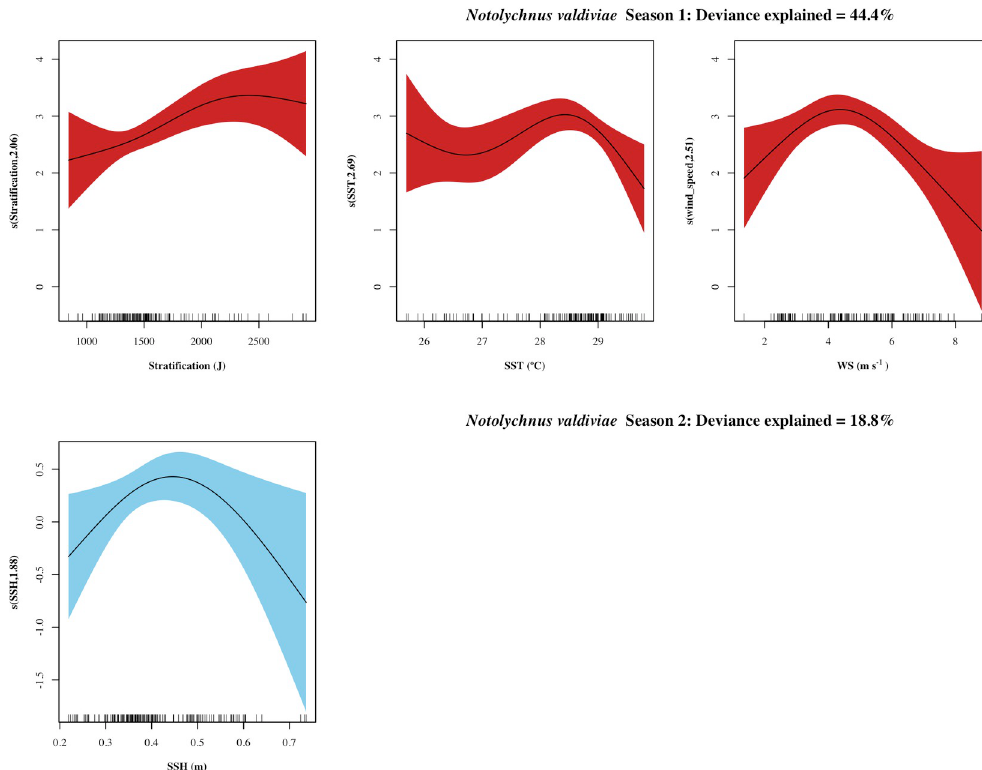
Fig 7. Response plots of the oceanographic variables’ additive effect on the density of Notolychnus valdiviae . Season I (April-July) in red and season II (August-October) in blue. Smoothed values represented by a continuous line, and shaded color indicates 95% confidence intervals. variables with non-significant additive effects (p > 0.05) for a given season are not